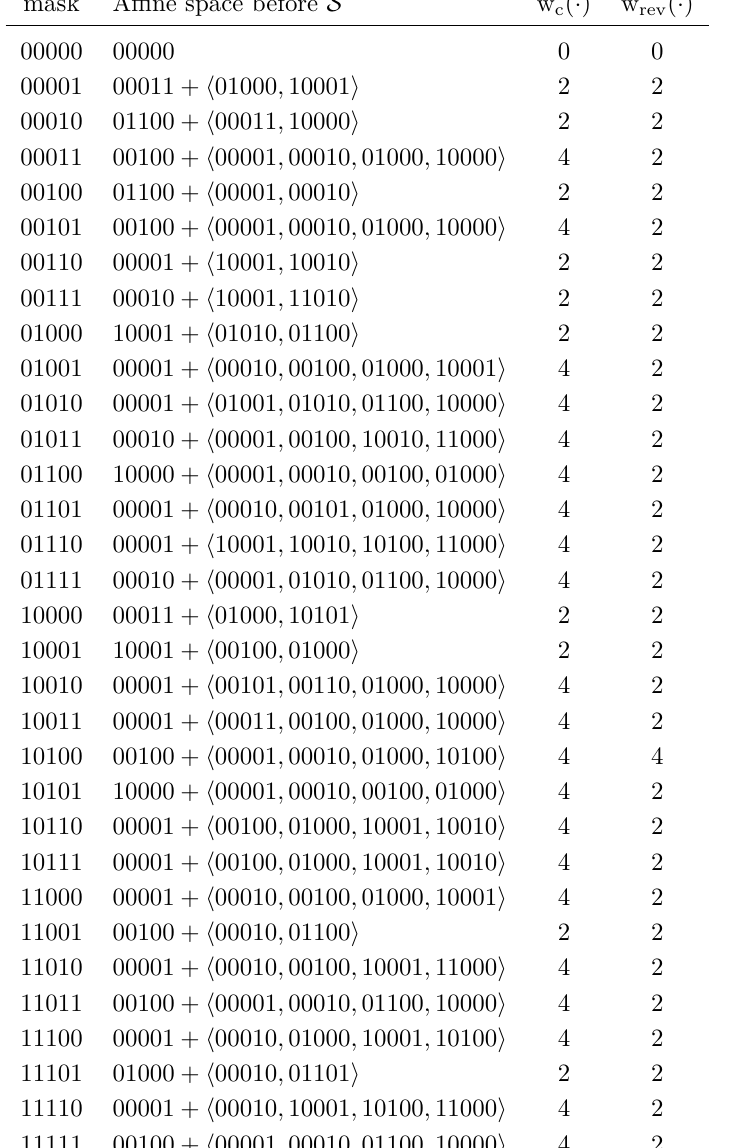
Table 8: Space of compatible masks at the input of p S , correlation weight, and minimum reverse weight for all possible column